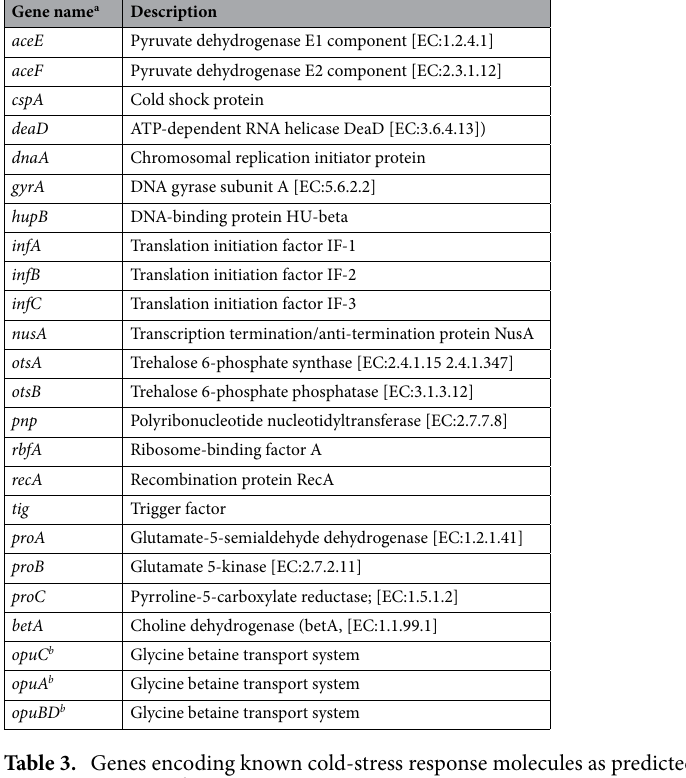
Table 3. Genes encoding known cold-stress response molecules as predicted in the AK-R2A1-2 T genome. a Barria, et al., 2013; b Hoffmann, et al.,